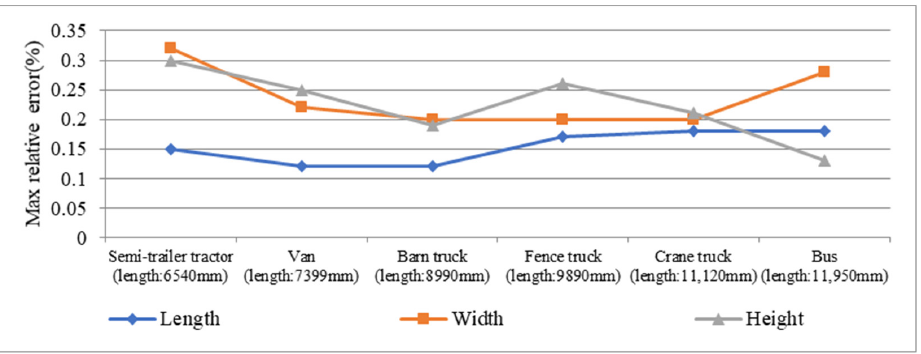
Figure 18. Max relative error of profile size of the five vehicles.